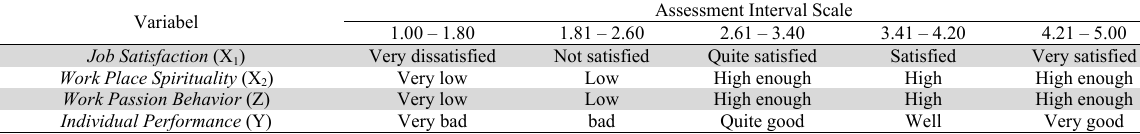
Rating Category Based on Scale